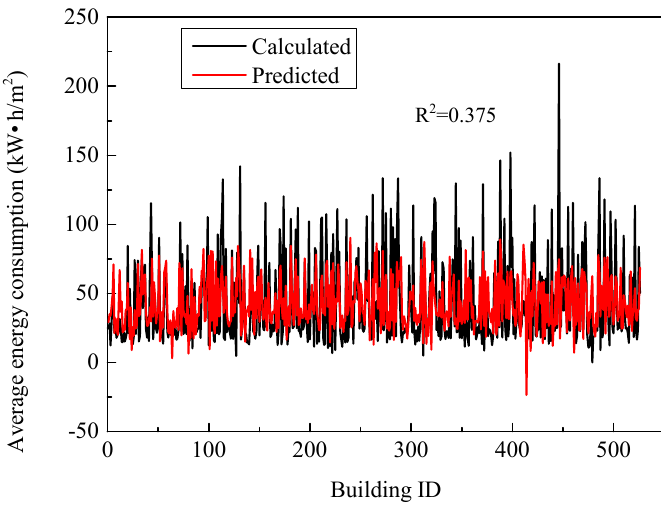
Figure 7. Comparisons of the multi-zone method and single-zone method.